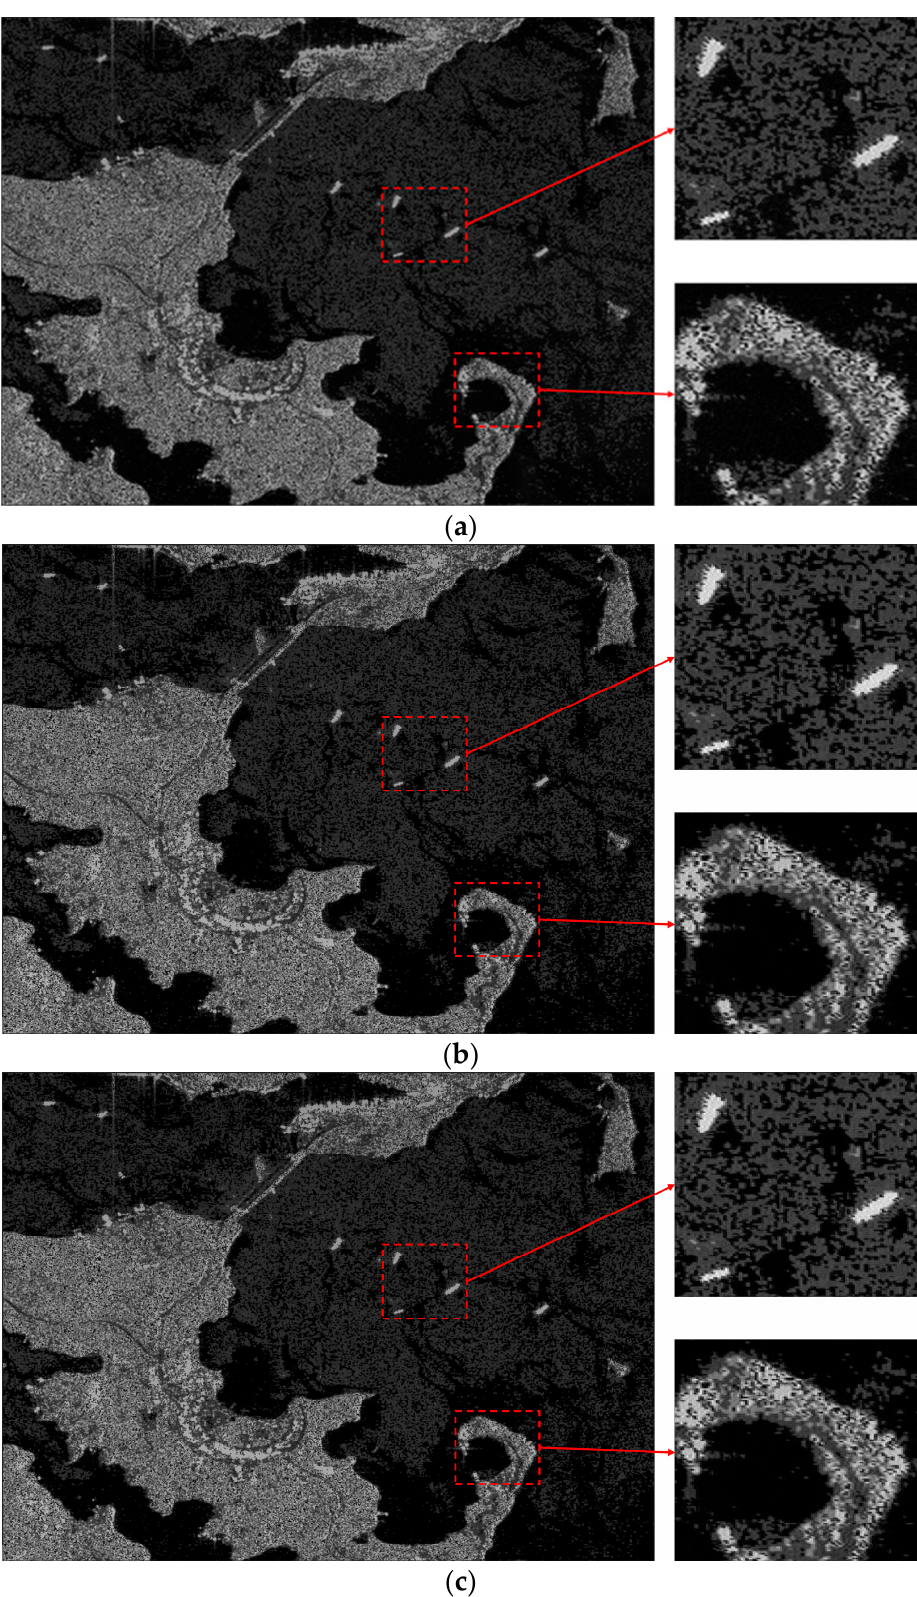
Figure 14. Reconstructed SAR image obtained by the di ff erent algorithms. ( a ) The bistatic BP algorithm; ( b ) The bistatic EP FFBP algorithm; ( c ) The proposed bistatic FFBP algorithm.